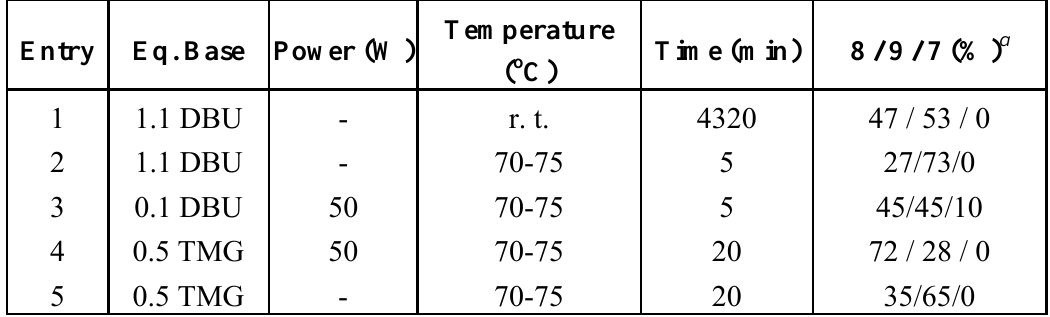
Table 2. Formation of 8 and 9 by 1,4–addition of nitromethane ( 2 ) to Methyl Methacrylate ( 7